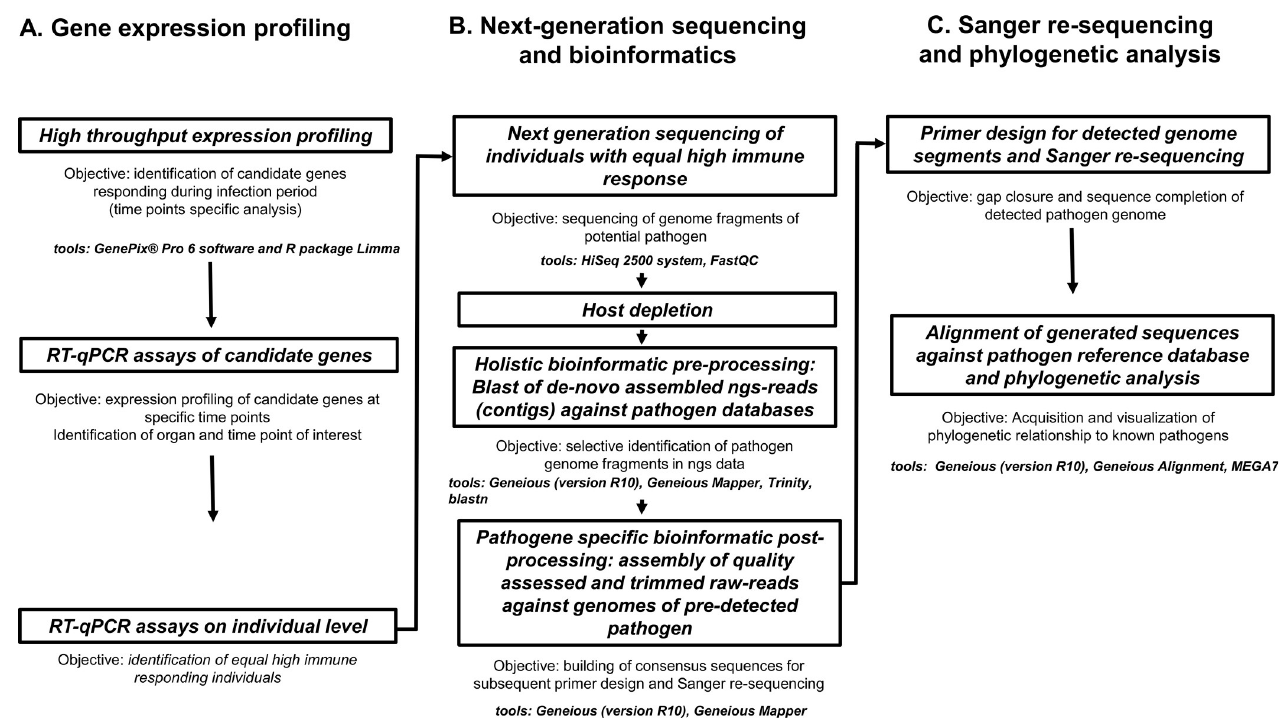
Fig 1. Schematic diagram visualizing the detection pipeline for an unknown pathogen in a non-model species in natural populations. Core steps in the workflow including the used tools from high throughput expression profiling to final phylogenetic analysis are displayed.